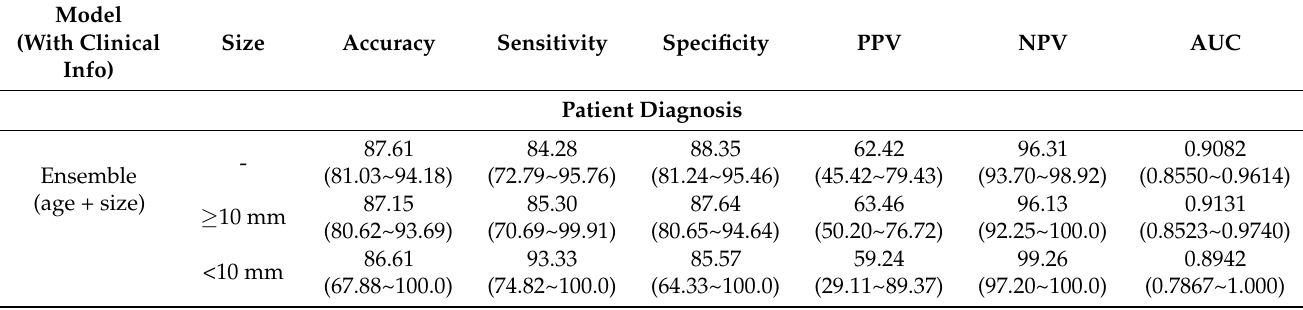
Table 3. Diagnostic performances of the ensemble model according to the polyp